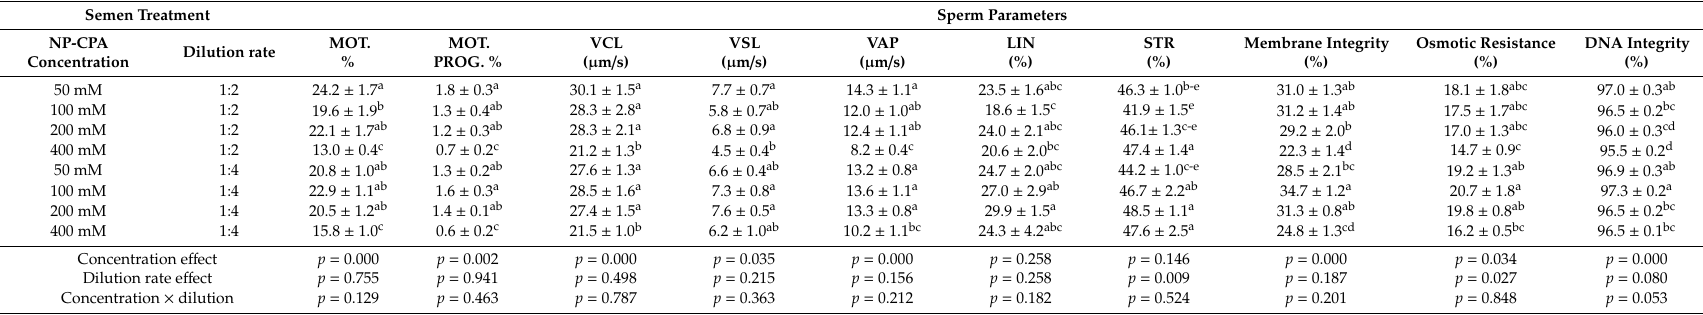
Table 4. Sperm quality parameters (mean ± S.E.M.) measured in turkey semen frozen in the presence of sucrose according to the di ff erent concentrations and two dilution rates (N =